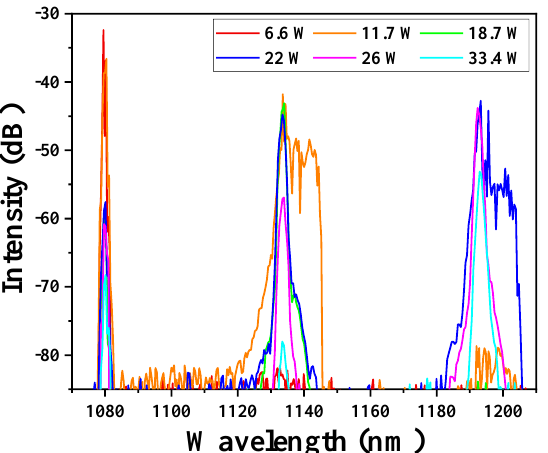
Figure 4. Spectrum evolution process under different powers of 1080-nanometer laser.